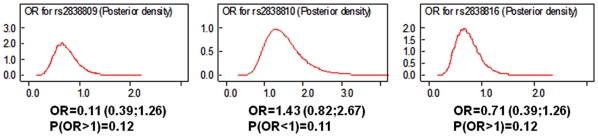
Posterior densities of ORs.Posterior densities of the ORs for the 3 SNPs in ADARB1 with rare alleles and moderate effects in the data aggregated from NECS, SICS and JCS. Significant associations would results in posterior densities not overlapping 1 and definite evidence of either an OR<1 or an OR>1, while all of the three densities have heavy tails and do not provide definite evidence against the null hypothesis of no association.